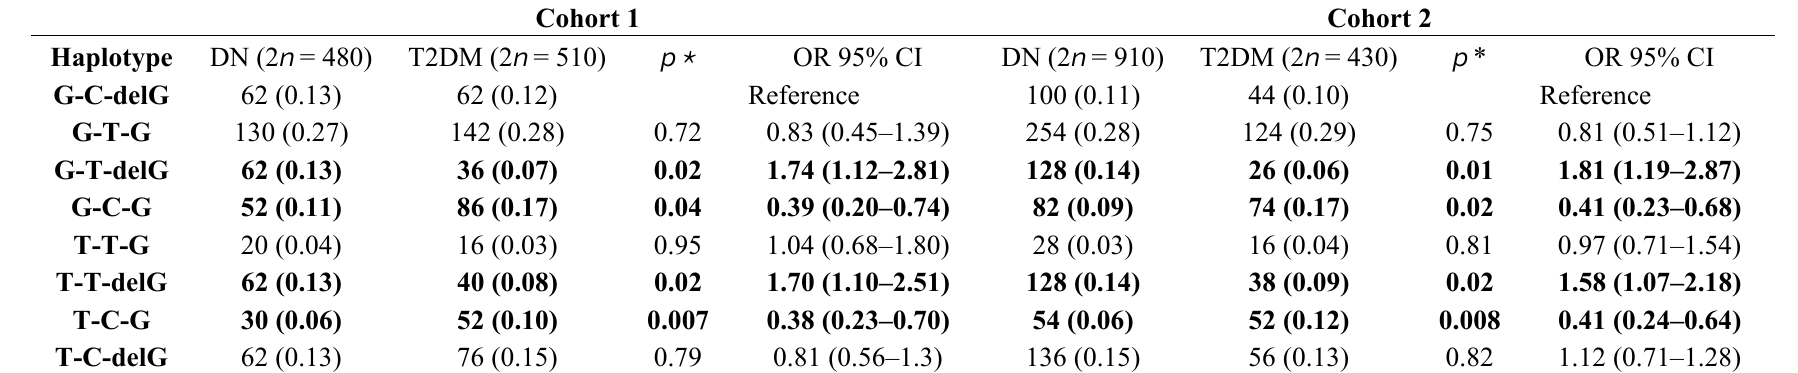
Table 3. Osteopontin ( OPN ) promoter gene haplotype frequency distribution in type 2 diabetes mellitus (T2D) vs. diabetic nephropathy (DN).